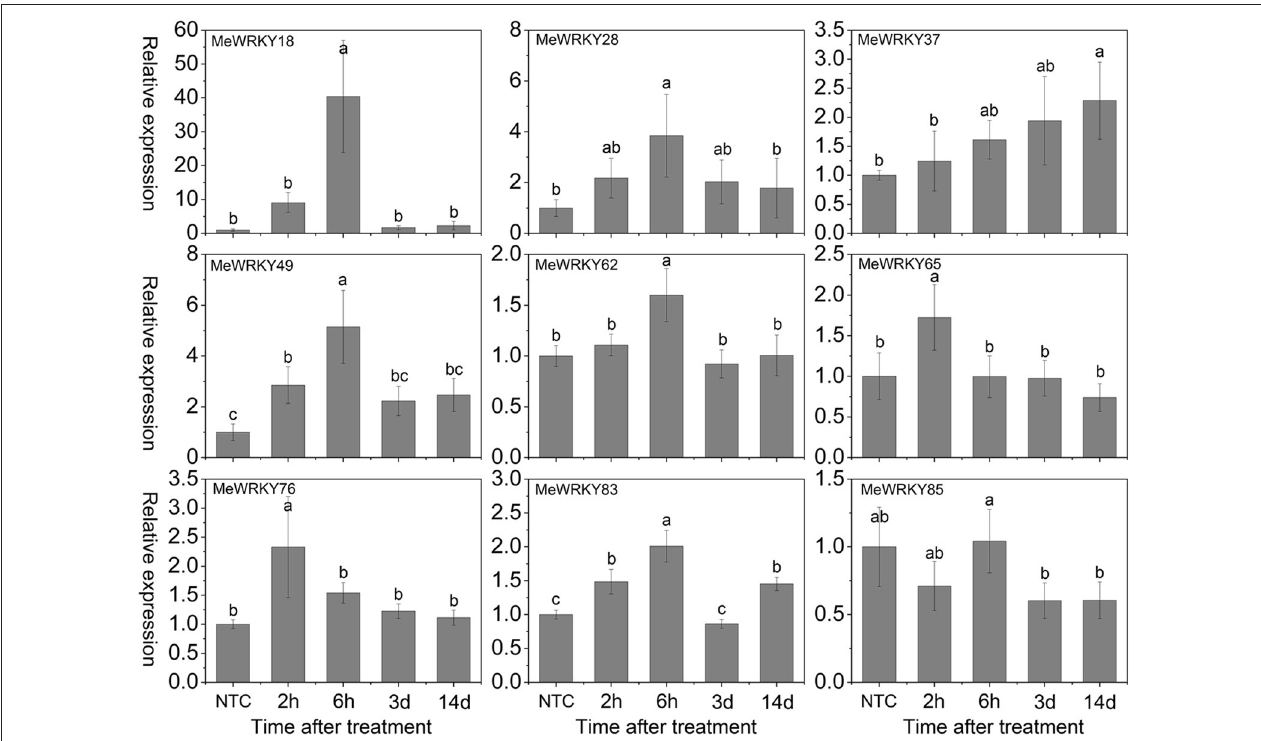
FIGURE 7 | Expression profiles of MeWRKY genes in leaves under osmotic stress. The relative expression levels of MeWRKY genes in each treated time point were compared with that in each time point at normal conditions. NTC (no treatment control) at each time point was normalized as “1.” Data are means ± SE calculated from three biological replicates. Values with the same letter were not significantly different according to Duncan’s multiple range tests ( P < 0.05 , n = 3 ).